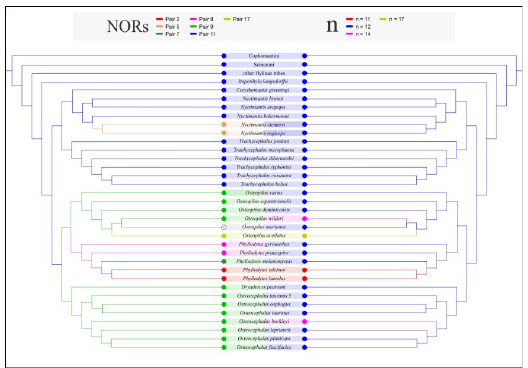
Fig 3. Ancestral character state reconstruction of the position of NORs (left) and the haploid number (right) in Lophyohylini on a condensed tree from the phylogenetic hypothesis of Blotto et al. [3]. For the complete optimizations including all taxa see S2